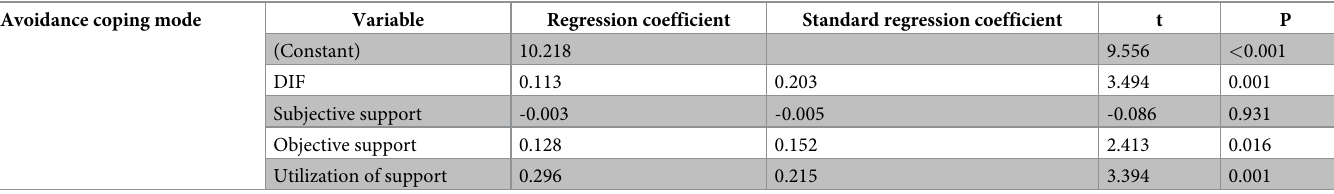
Table 8. Multivariate analysis of the avoidance coping mode among patients treated with IVF-ET. Avoidance coping